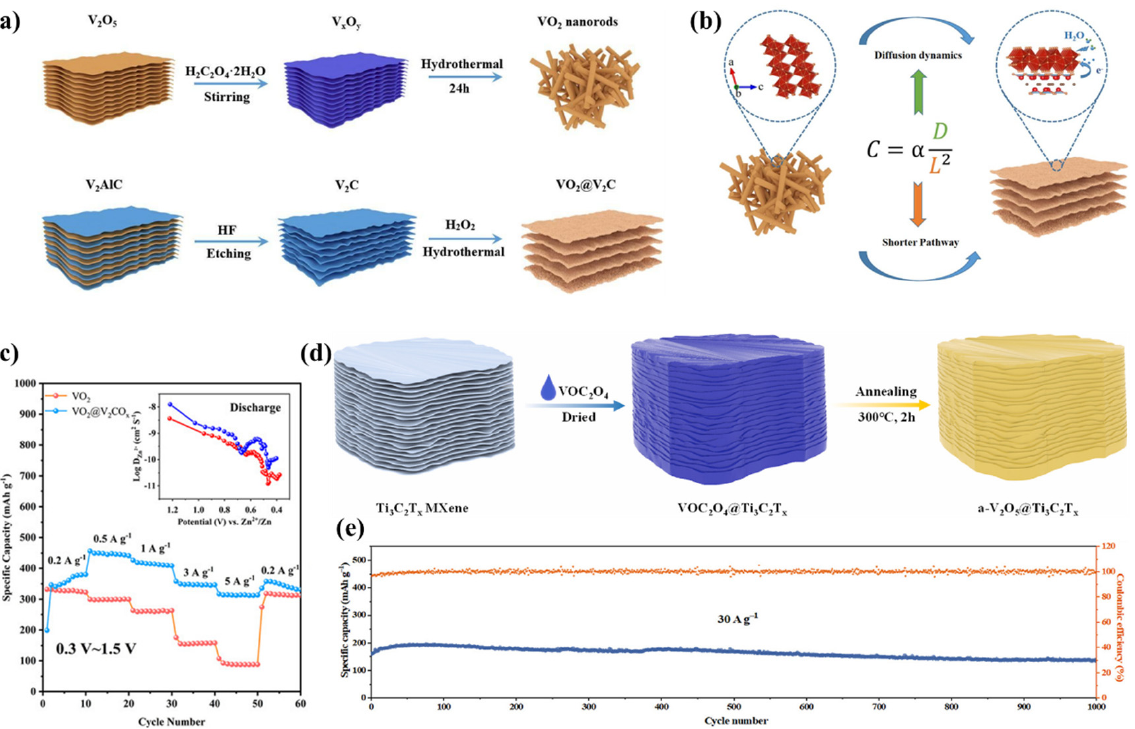
Figure 8. ( a ) Preparation process chart of VO 2 nanorods and VO 2 @V 2 C (Ref. [78]). ( b ) The rate performance improvement diagram of VO 2 @V 2 C relative to VO 2 (Ref. [78]). ( c ) Rate performance diagrams for VO 2 and VO 2 @V 2 C (Ref. [78]). ( d ) Synthesis schematic of a − V 2 O 5 @Ti 3 C 2 T x (Ref. [79]). ( e ) Long cycle performance of a − V 2 O 5 @ Ti 3 C 2 T x (Ref. [79]).